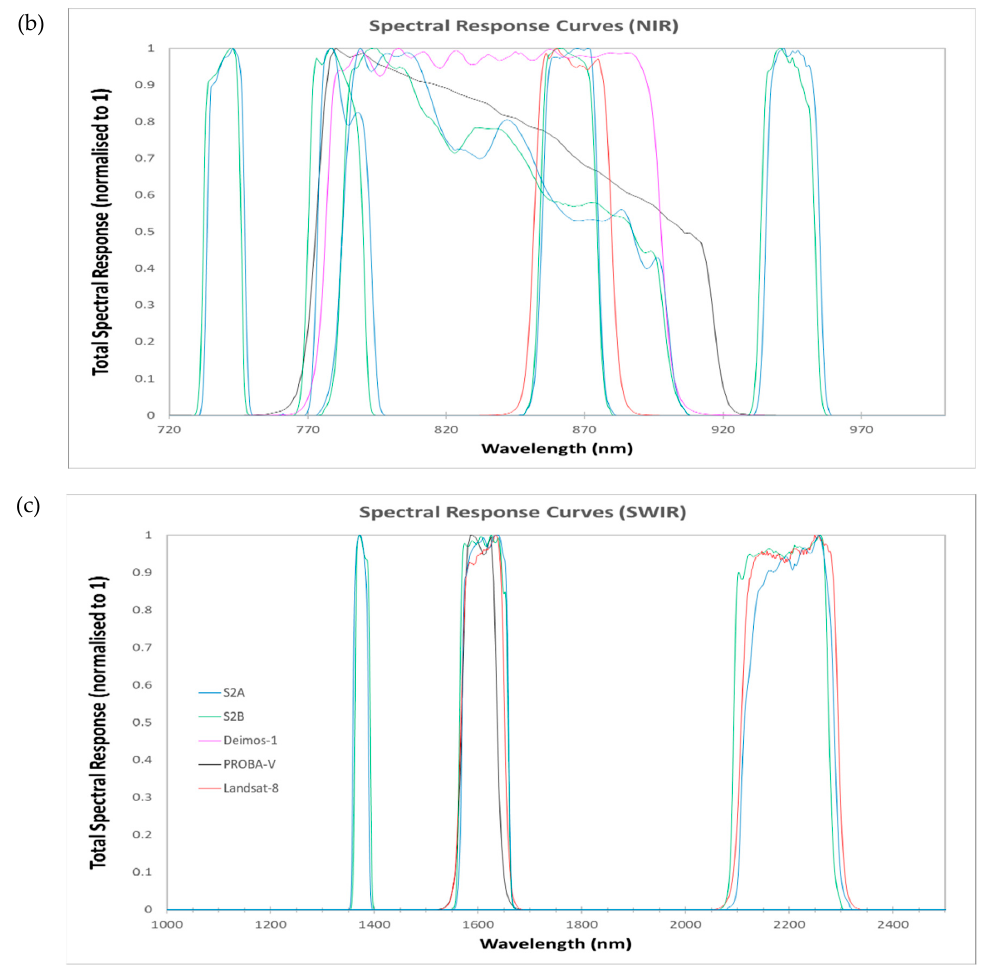
Figure 1. Spectral response curves for all sensors divided into three spectral ranges: ( a ) VIS (400–720 nm), ( b ) NIR (720–1000 nm), and ( c ) SWIR (1000–2500